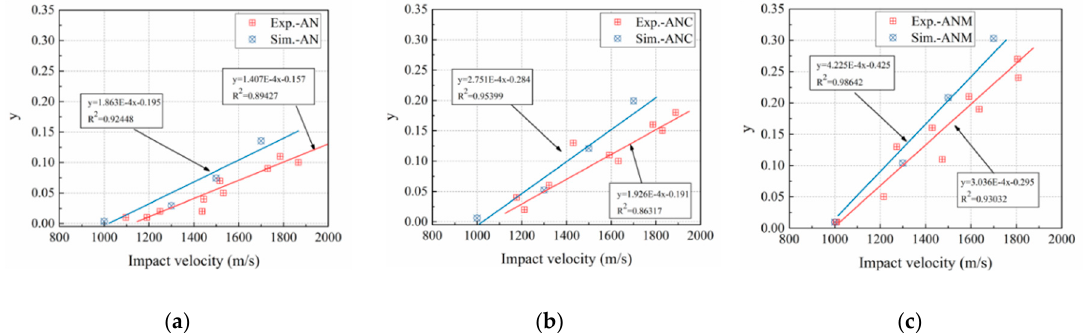
( b ) Figure 15. Time-history curve of the extent of the chemical reaction for three units of the Ai/Ni-based RMs at an impact velocity of 1300 m/s: ( a ) location of elements; ( b ) time-history curves of the extent of the chemical reaction y . The time-history curve information of the extent of the chemical reaction y for all of the units in